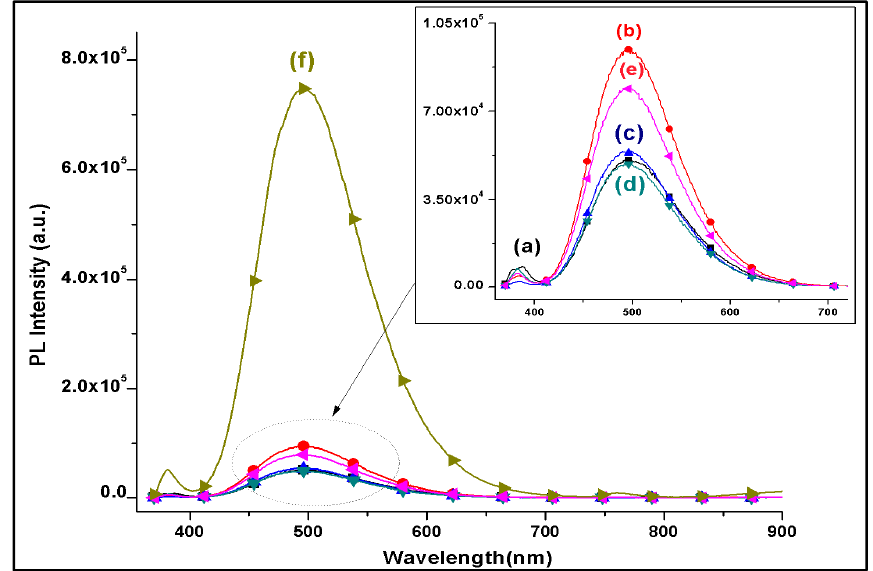
Figure 12. Photoluminescence spectra of ( a ) ZnO film and ZnO:Ta-doped films with ( b ) 10% Ta 2 O 5 , ( c ) 20% Ta 2 O 5 , ( d ) 40% Ta 2 O 5 , ( e ) 50% Ta 2 O 5 , and ( f ) 60% Ta 2 O 5 in the pellet source.